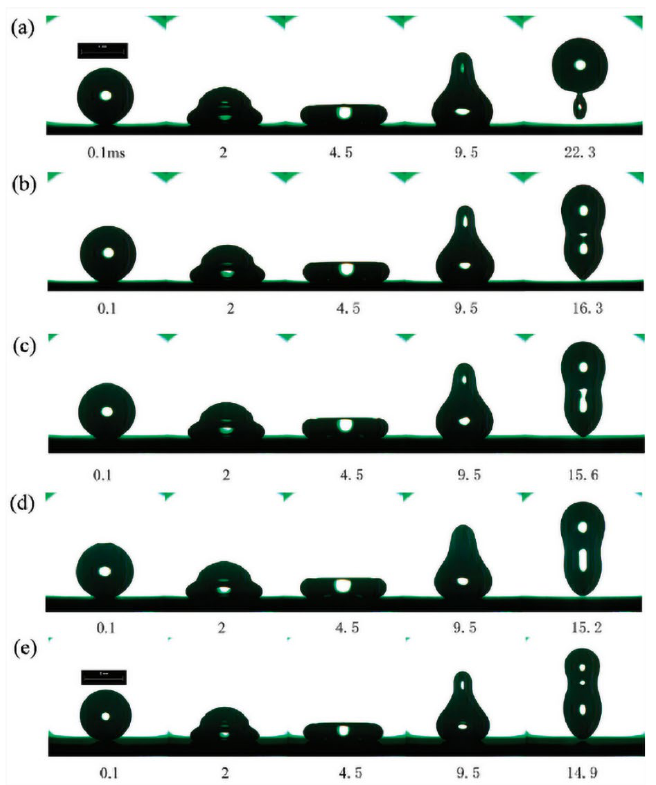
Figure 14. Schematic illustration for the result of high-speed camera methodology. Sequential images show the temporal evolution of the dynamic impact drop on different surfaces. The impact velocity was set up to 0.54 m/s, and then parts ( a – e ) represent drop events on the T 20 textured surfaces, respectively. Reprinted with permission from Ref. [128]. Copyright@2010,